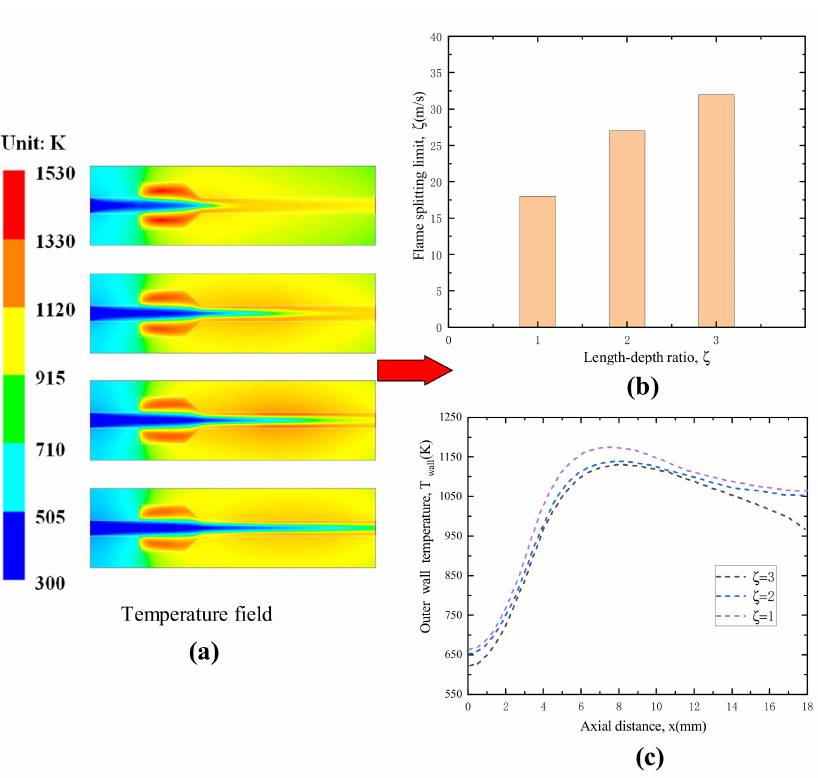
Figure 13. Flame splitting limit and wall temperature for different length-depth ratios. ( a ) Tempera- ture field, ( b ) Flame splitting limit, ( c ) Outer wall